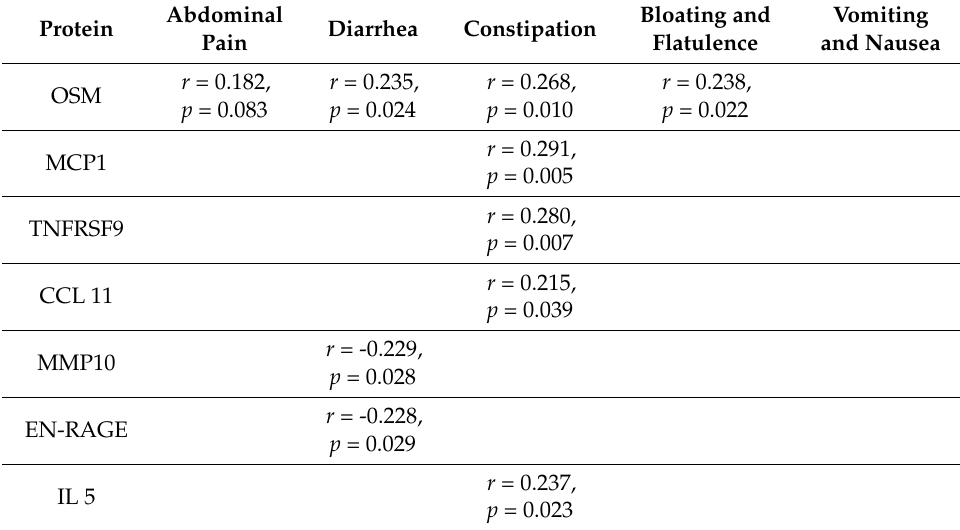
Bloating and Vomiting Flatulence and